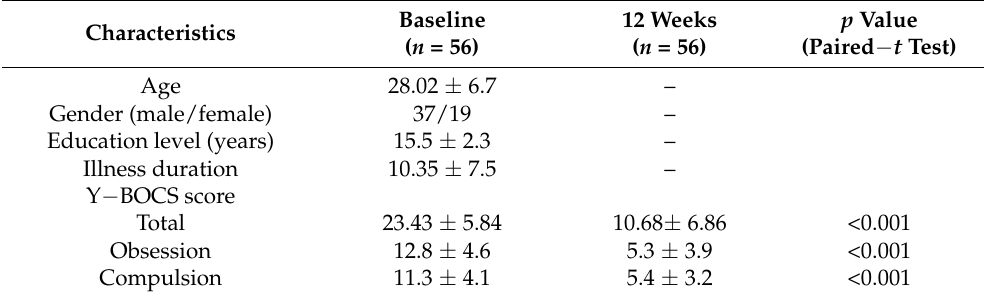
Table 2. Demographic and clinical characteristics of OCD patients before and after